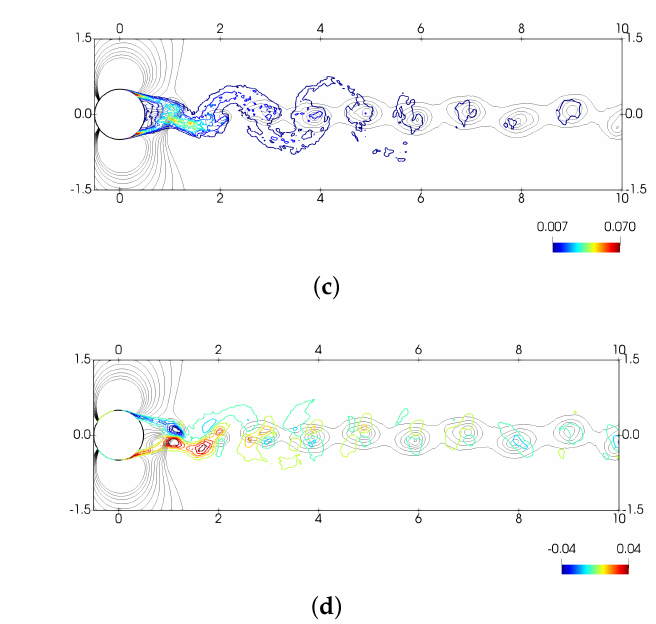
Figure 17. Contours of the random component of the normal and shear stresses at constant phase, φ = 0, plotted over pressure coefficient contours (in black) ( a ) (cid:104) u (cid:48) (cid:105) / U 2 (cid:105) / U 2 u (cid:48) u (cid:48) ( c ) (cid:104) u (cid:48) , ( d ) (cid:104) u (cid:48) 3 3 2 1 ref ref